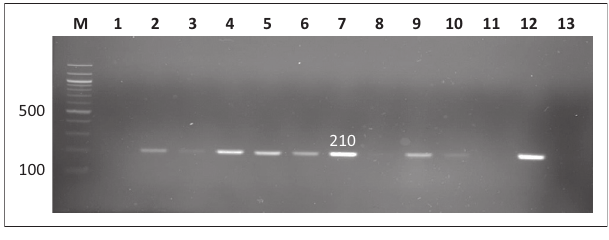
FIGURE 9: Detection of the 210 bp tet A gene amplicon from seven representative Salmonella isolates by agarose gel electrophoresis.